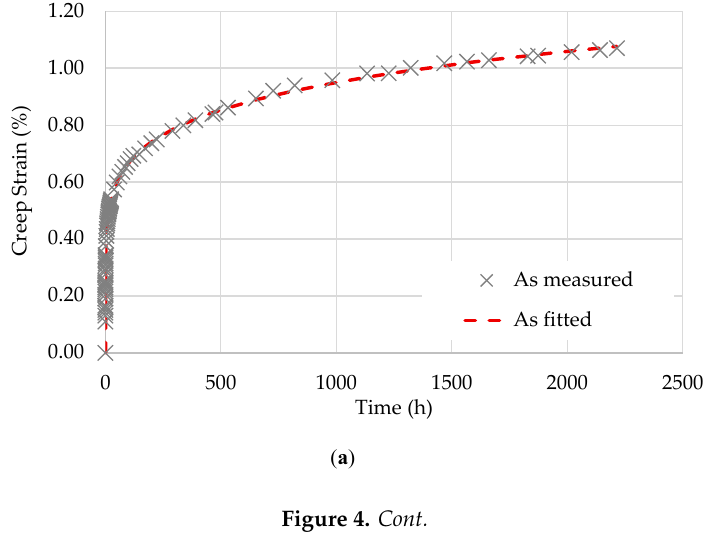
( b ) Figure 4. T28-S35: ( a ) data fitting; ( b ) full path of creep and transition points. Based on 𝐷 (cid:2868) , the compliance in the glassy state is given by 𝐷 (cid:2868) = 𝑘 𝜎(cid:3415) . Table 3 summarizes the values of 𝐷 (cid:2868) and the parameters used to obtain the creep compliance for each stress level. Table 3. Parameters to obtain the creep compliance by EPL expression. Specimen